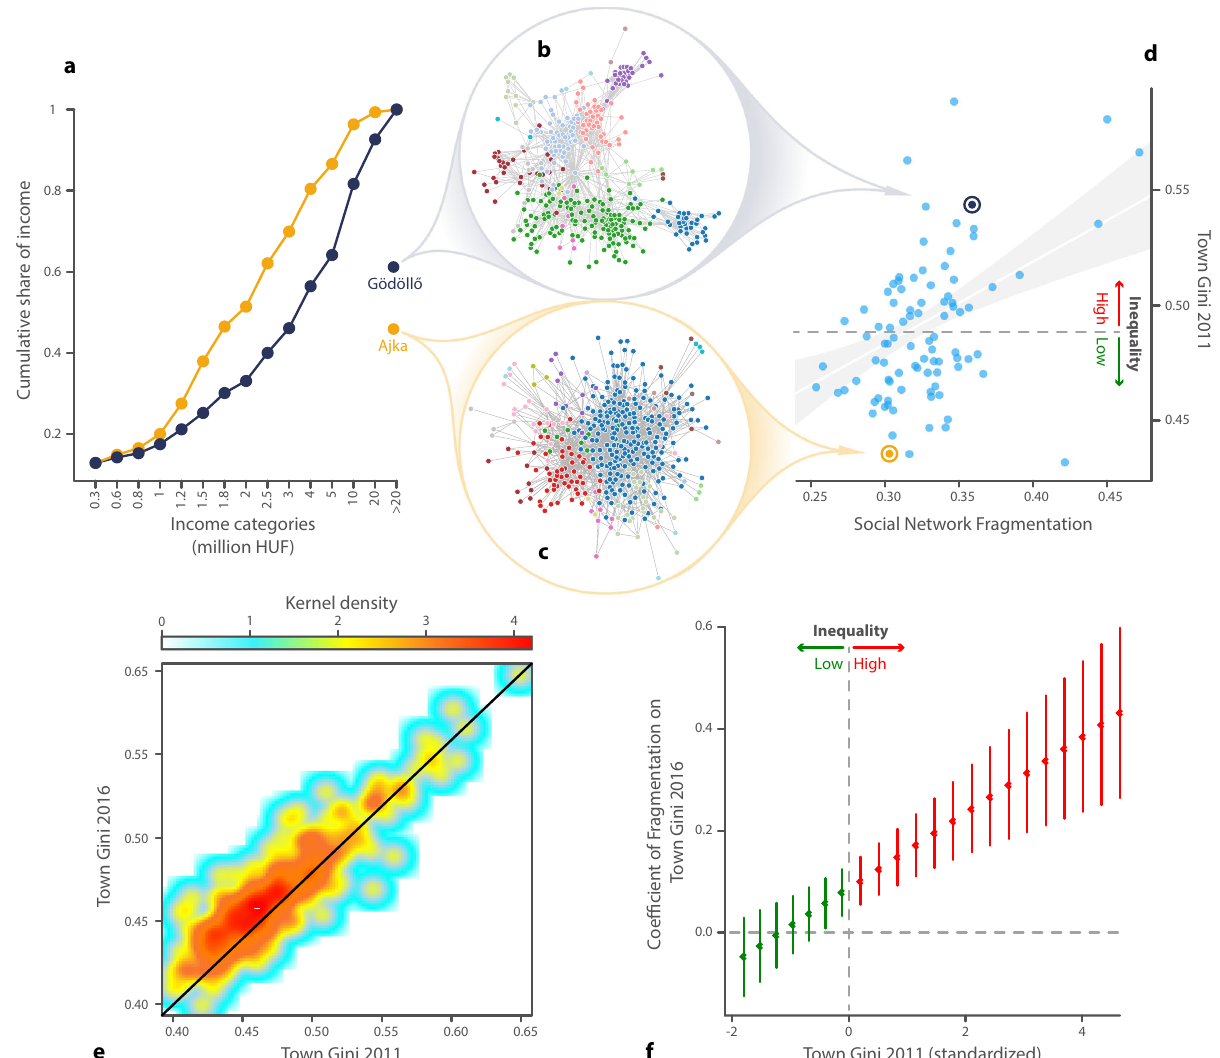
Fig. 1 Income inequality ( G i ) correlates with network fragmentation ( F i ) in towns. a Cumulative distribution of income in a relatively equal town (Ajka, gold) and a relatively unequal one (Gödöll ő , dark blue). Sampled social networks in Gödöll ő ( b ) and Ajka ( c ). Node colors represent network communities revealed by the Louvain method in both networks. d Income inequality measured by the Gini index ( G i ,2011 ) for towns with more than 15,000 inhabitants ( n = 91) correlates with the fragmentation ( F i ) of their social networks (Pearson ’ s ρ = 0.44). Gold dot: Ajka ( G i ,2011 = 0.43, F i = 0.3); dark blue dot: Gödöll ő ( G i ,2011 = 0.54, F i = 0.36); blue dots: all other towns. Fitted line represents a linear regression G i ,2011 = 0.36 + 0.37 F i with R 2 = 0.198. The shade area depicts 95% con fi dence interval. The dashed horizontal line represents the mean of G i ,2011 = 0.488. e We plot the correlation between town Gini scores in 2011 and 2016 ( G i ,2011 and G i ,2016 ). f The relationship between network fragmentation ( F i ) and inequality in 2016 is stronger in those towns where initial inequality ( G i ,2011 ) is high. β , the marginal effect of town social network fragmentation ( F i ) on the Gini of the town in 2016 ( G i ,2016 ), becomes signi fi cant ¼ 0. It increases as G i around the mean of the Gini in 2011 ( G i ,2011 ) i.e. at Z G ,2011 grows. Points depict estimated marginal effects at the mean and bars i ; 2011 represent their 95% con fi dence intervals ( n =